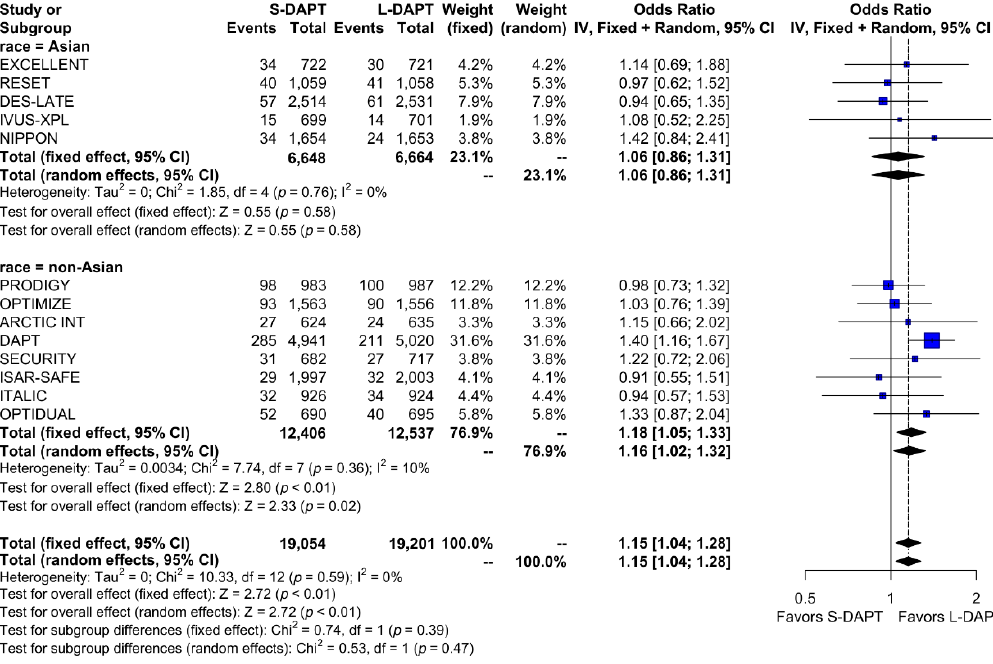
Figure 2. Primary outcome in randomized clinical trials. S-DAPT, short duration dual antiplatelet therapy; L-DAPT, long duration dual antiplatelet therapy; CI = confidence interval.